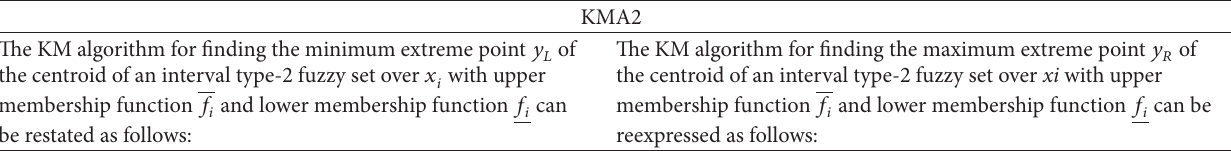
Table 2: KMA2 algorithm flow.